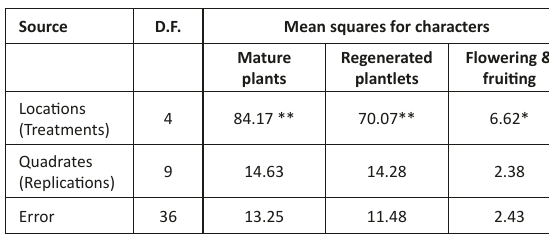
Table 2. Analysis of Variance (ANOVA) for three parameters of natural populations of Ensete superbum .